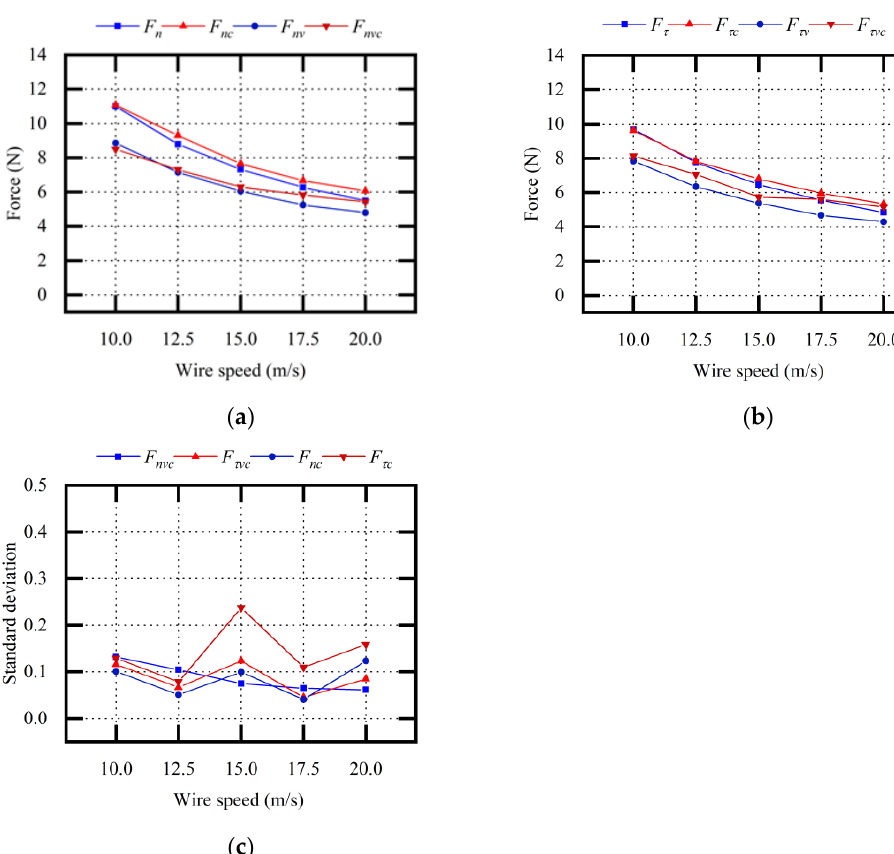
Figure 9. Comparative analysis of sawing force (variable v τ ): ( a ) normal sawing force; ( b ) tangential sawing force; ( c ) standard deviation σ 1 of experimental values.